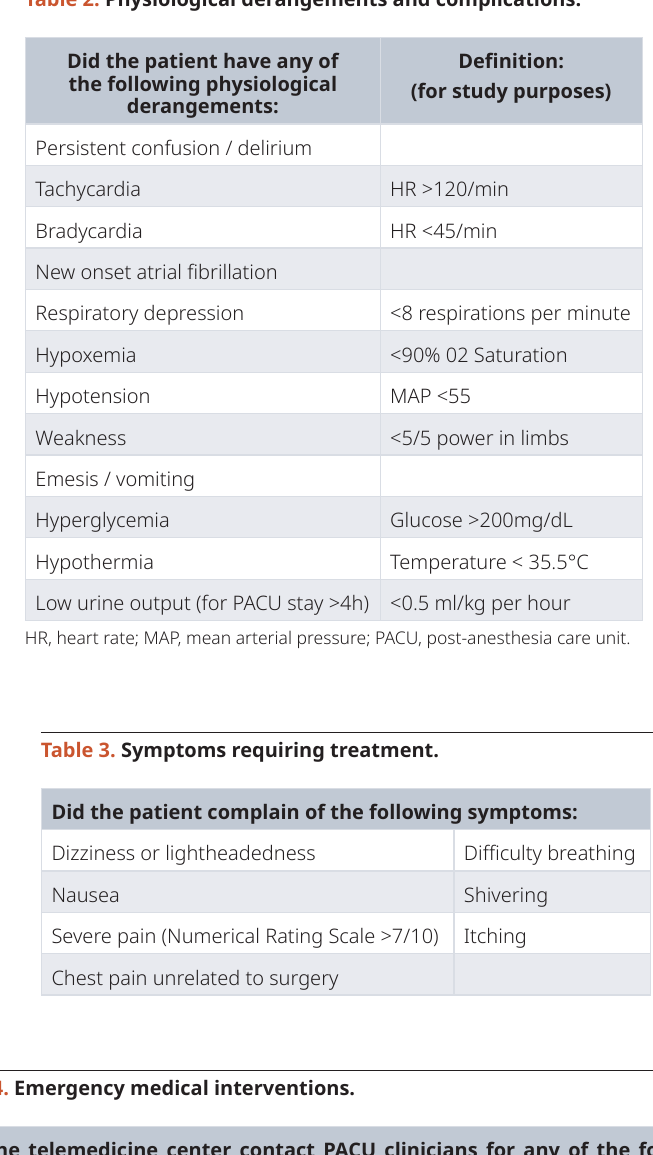
Table 2. Physiological derangements and complications.